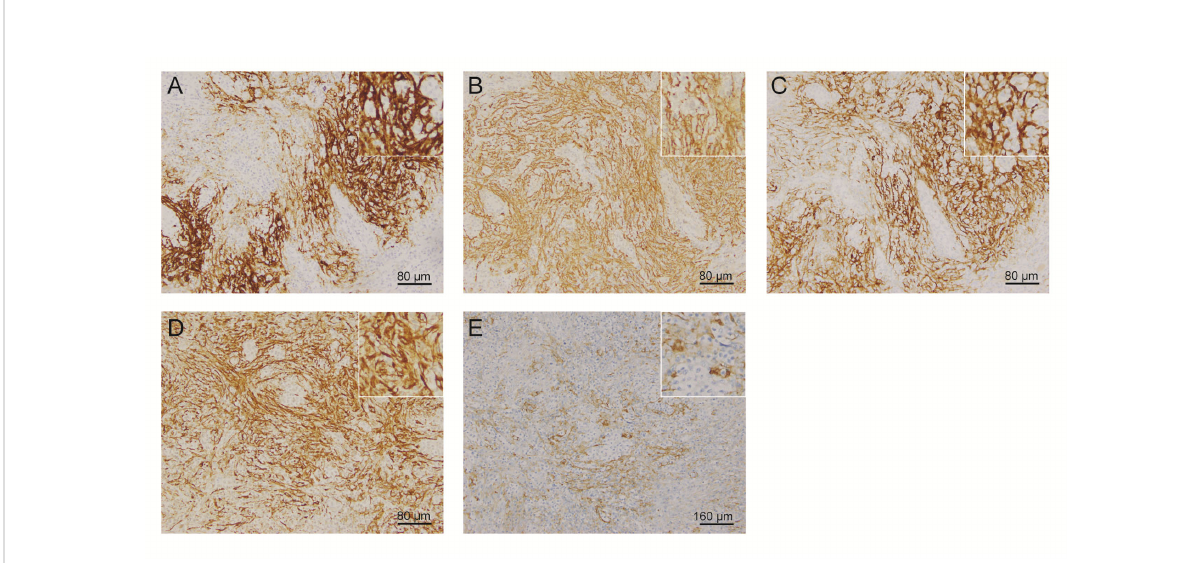
FIGURE 3 Representative IHC staining images of spindle cells. Spindle cells were positive for (A) CD21, (B) CD23, (C) CD35, (D) desmin, and (E) SMA. (IHC, immunohistochemistry; SMA, smooth muscle actin).